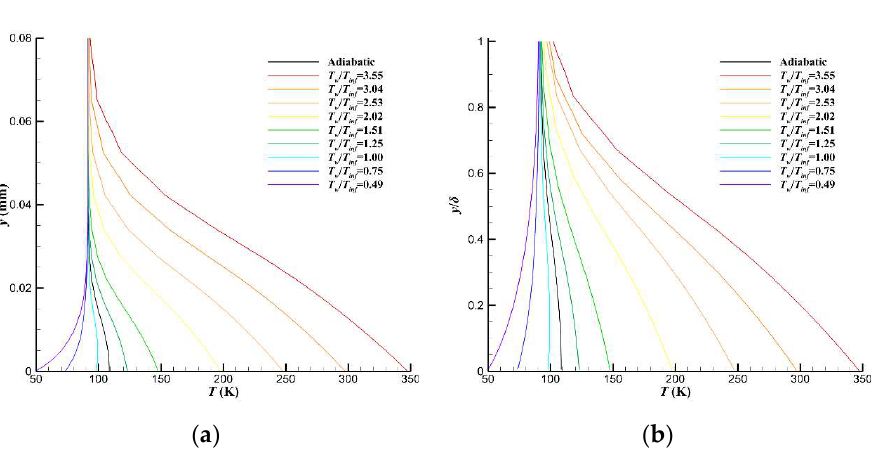
Figure 19. Temperature distribution of laminar boundary layers. ( a ) T v.s. y ; ( b ) T v.s. y / δ .